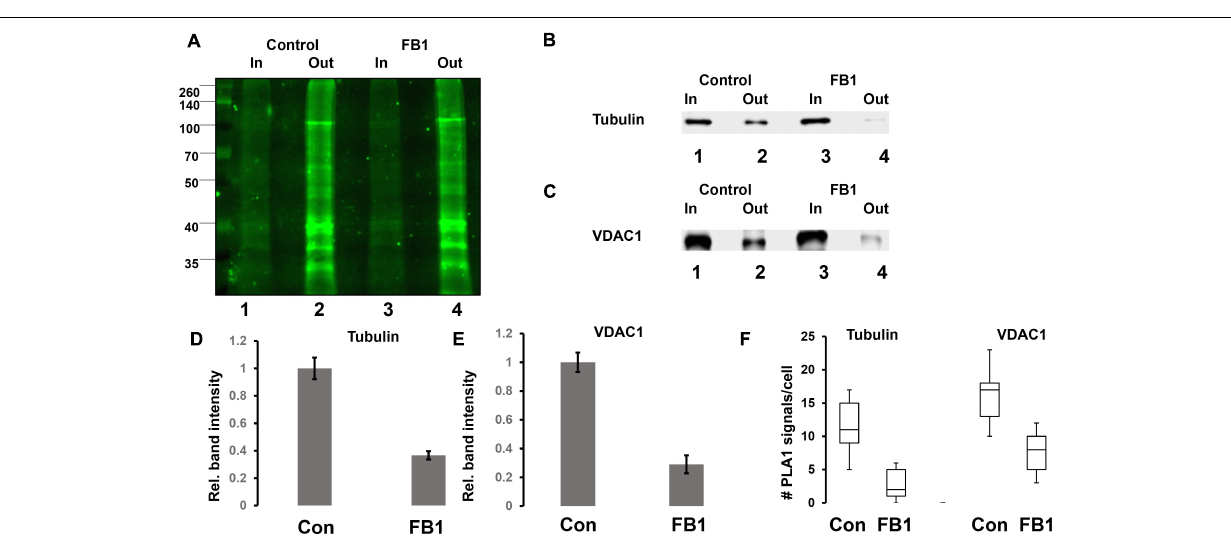
FIGURE 6 | Ceramide depletion reduces cross-linking of pacFACer to tubulin and VDAC1. (A) N2a cells with or without pre-incubation for 48 h with 5 µ M FB1 were treated with pacFACer and cross-linked protein isolated and separated by SDS-PAGE as described in the legend for Figure 2 . Lane 1, input for pull-down of pacFACer cross-linked protein from non-treated control cells; lane 2, output from pull-down; lane 3, input for pull-down of pacFACer cross-linked protein from FB1-treated cells; lane 4, output from pull-down. (B,C) Assay performed as described in (A) , but gel immunoblotted and probed with antibodies to tubulin (B) and VDAC1 (C) . (D) Quantitation of (B) . n = 7, P < 0.05. (E) Quantitation of (C) . n = 5, P < 0.005. (F) Quantitation of PLA1 signals for pacFACer cross-linked tubulin and VDAC1 in primary cultured astrocytes with or without ceramide depletion by incubation with FB1. n = 5, P <